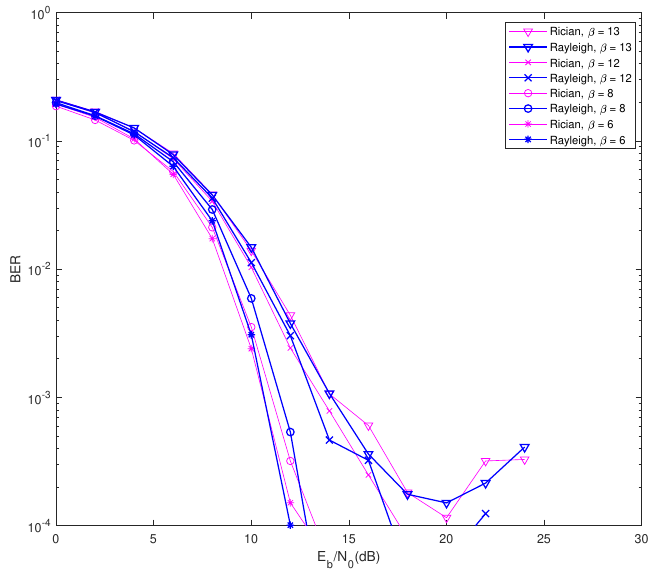
Figure 6. BER performance of R i in Rician fading and Rayleigh fading condition.